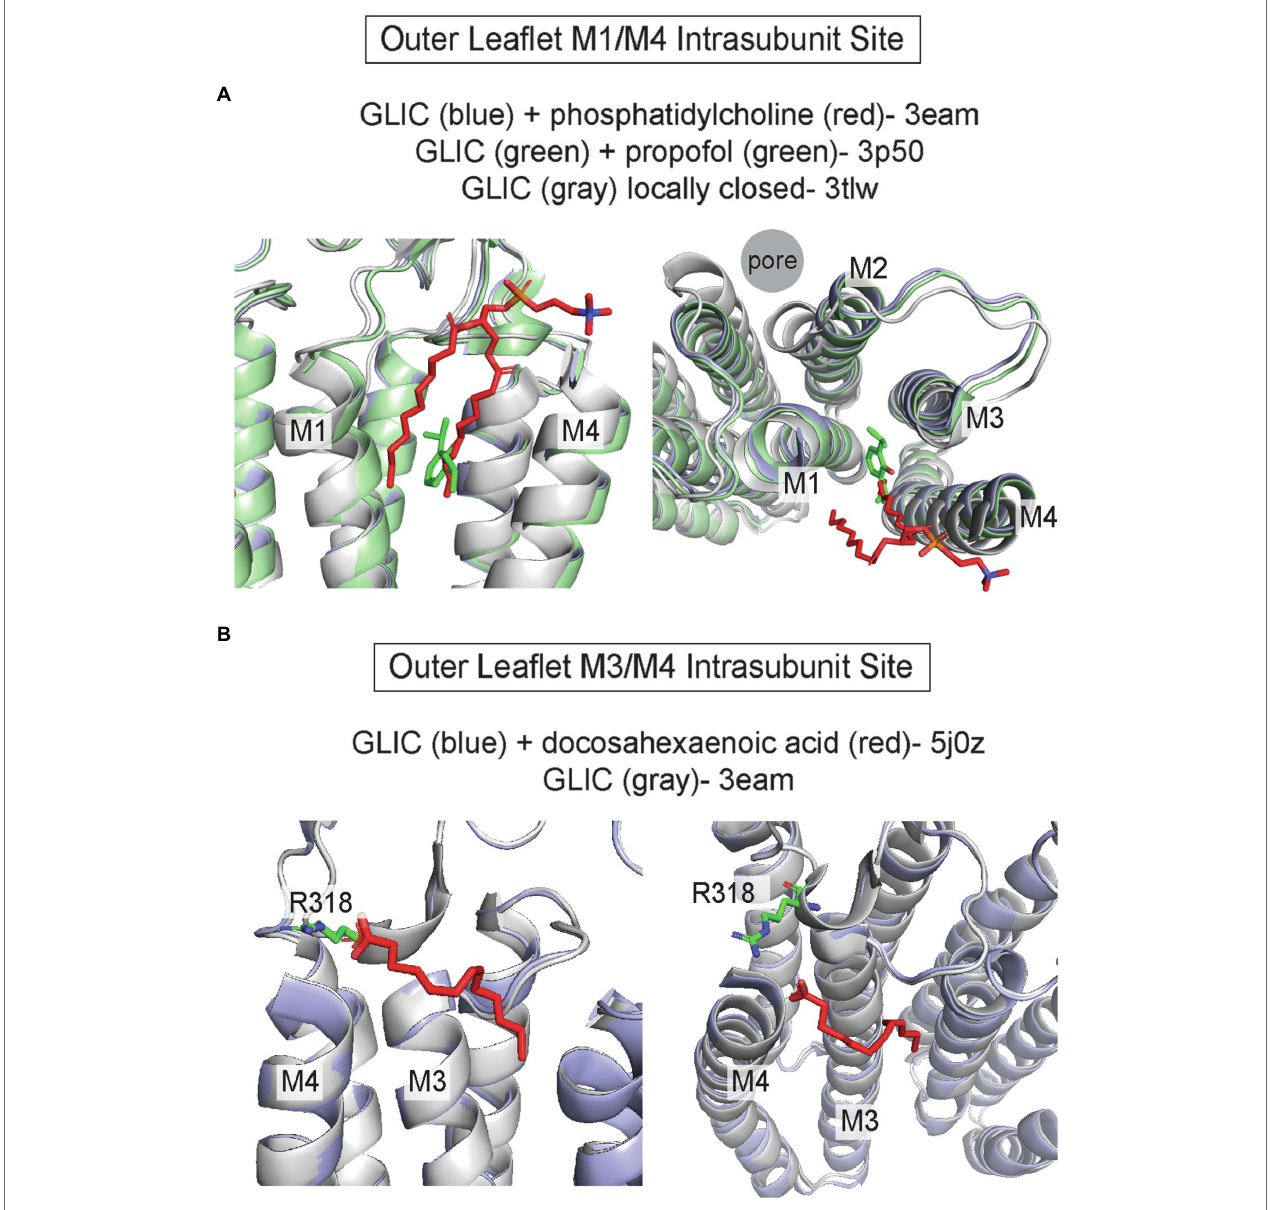
FIGURE 4 | Outer leaflet intrasubunit binding sites in pLGICs. (A) GLIC with phosphatidylcholine (pdb 3eam), GLIC with propofol (pdb 3p50), and the GLIC loop 2–21 ′ oxidized mutant which is a locally-closed conformation (pdb 3tlw). The +phosphatidylcholine and + propofol structures are similar while the locally-closed structure shows a tilting of the top of M2, M1 and M4 that reduces the size of the intrasubunit space between the helical bundles. (B) GLIC with docosahexaenoic acid (DHA; pdb 5j0z), which is similar to the structure of GLIC without DHA (pdb 3eam). R118 in the β 6- β 7 loop likely forms an ionic interaction with the DHA carboxylate